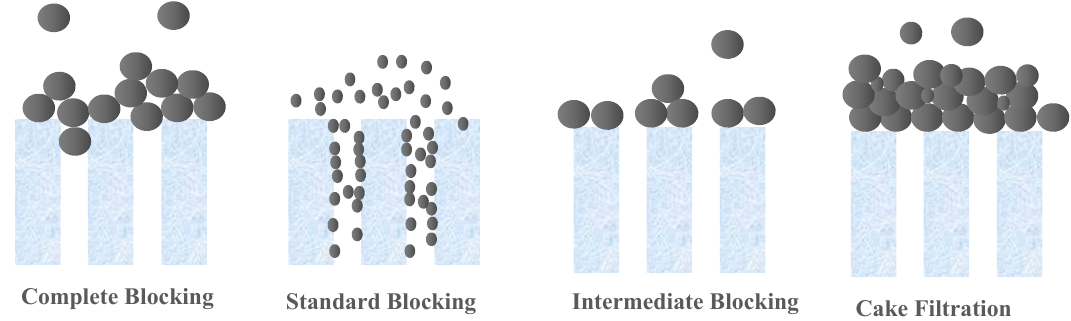
Figure 1. Schematic representation of various fouling mechanisms by particulate foulants [36].